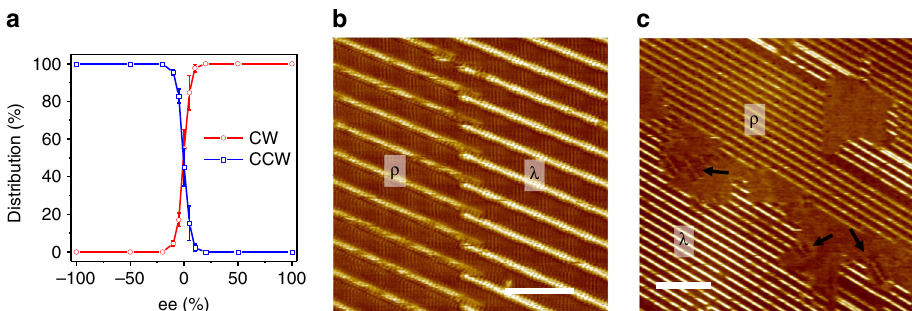
Fig. 6 Nonlinear ampli fi cation of chirality in enantiomerically unbalanced supramolecular bilayers. a Distribution of the CW and CCW structures of FAC18 on graphite as a function of the enantiomeric excess (ee) in the solution phase, where ee = ( L − D )/( L + D ). The δ phase was not taken into account. The error bars in a were calculated as a s.d. of at least three measurements. b STM image of the CW structure of a ( L )-FAC18:( D )-FAC18 = 3:2 mixture, showing the coexistence of λ and ρ domains. I set = 200 pA, V bias = − 600 mV. c STM image showing the submonolayer coverage of the racemate. Black arrows indicate the monolayer δ phase of the racemate. I set = 20 pA, V bias = − 600 mV. Scale bars: b 10 nm; c